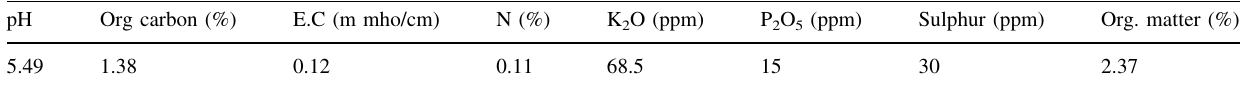
Table 1 Chemical analysis of soil